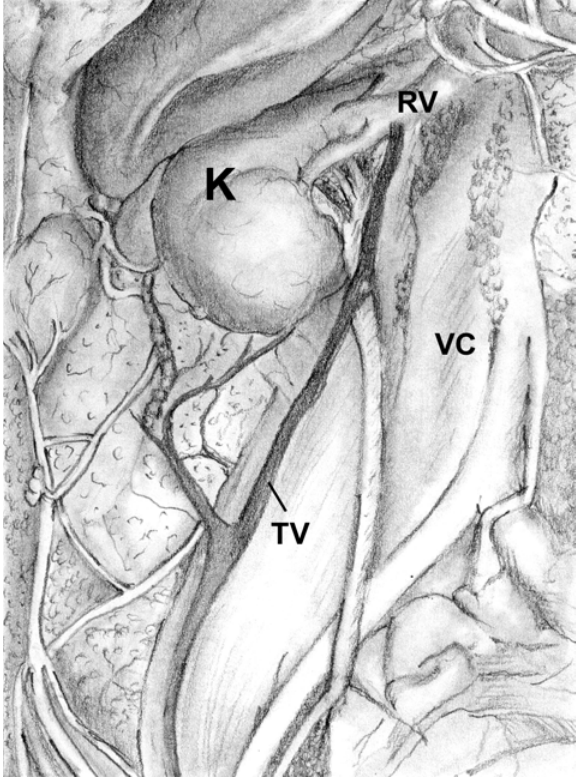
Figure 1 – Schematic drawing highlights a cadaver where the right testicular vein (TV) discharges in the right renal vein (RV). VC = inferior vena cava; K =